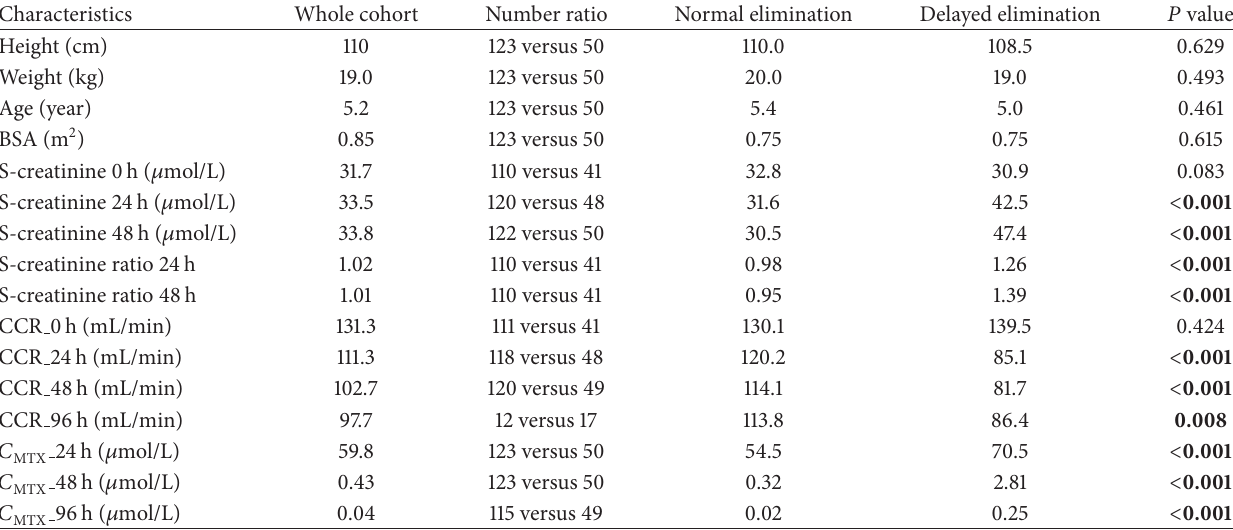
Table 1: Comparison of patients’ characteristics and serum MTX concentrations between patients with and without MTX elimination delay. Characteristics